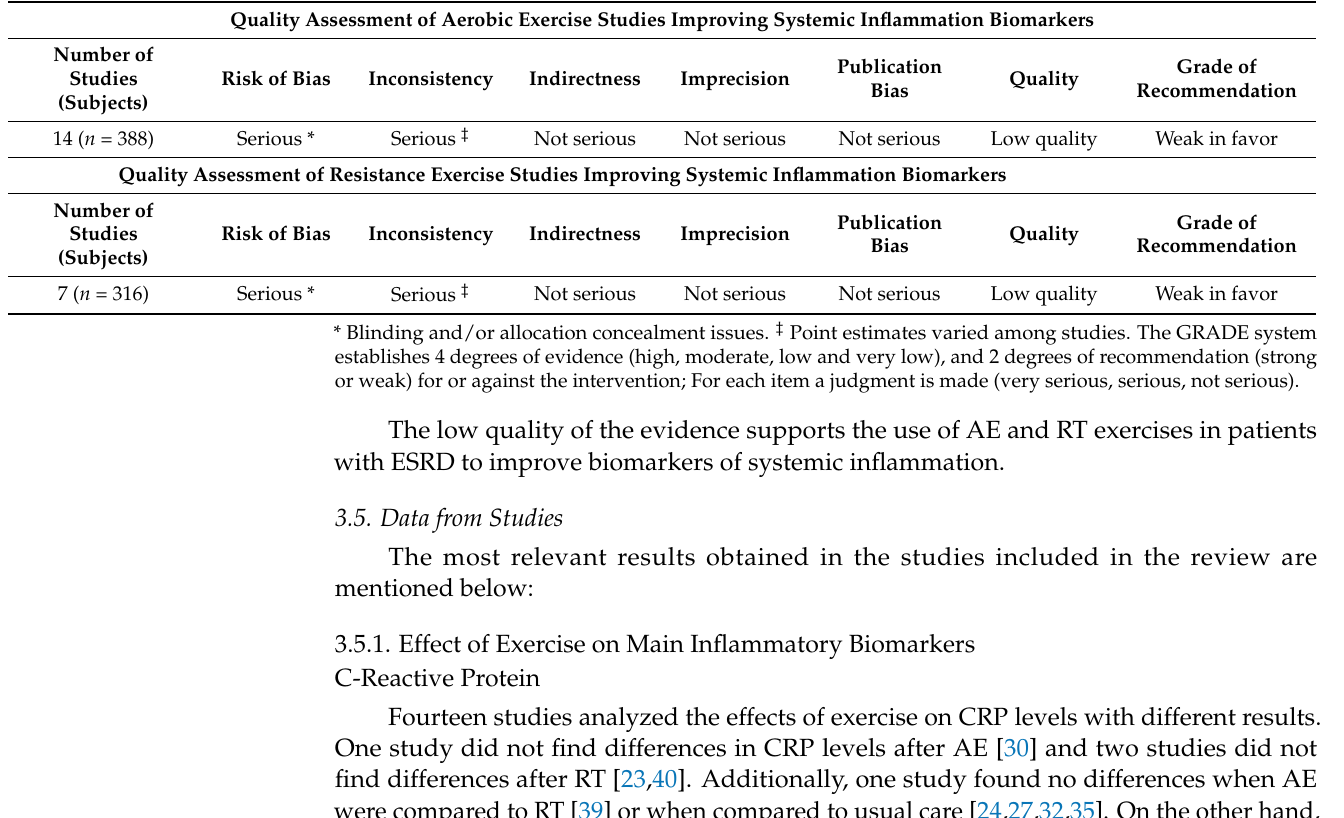
Table 5. Summary of findings for clinical trials, including the GRADE quality of evidence